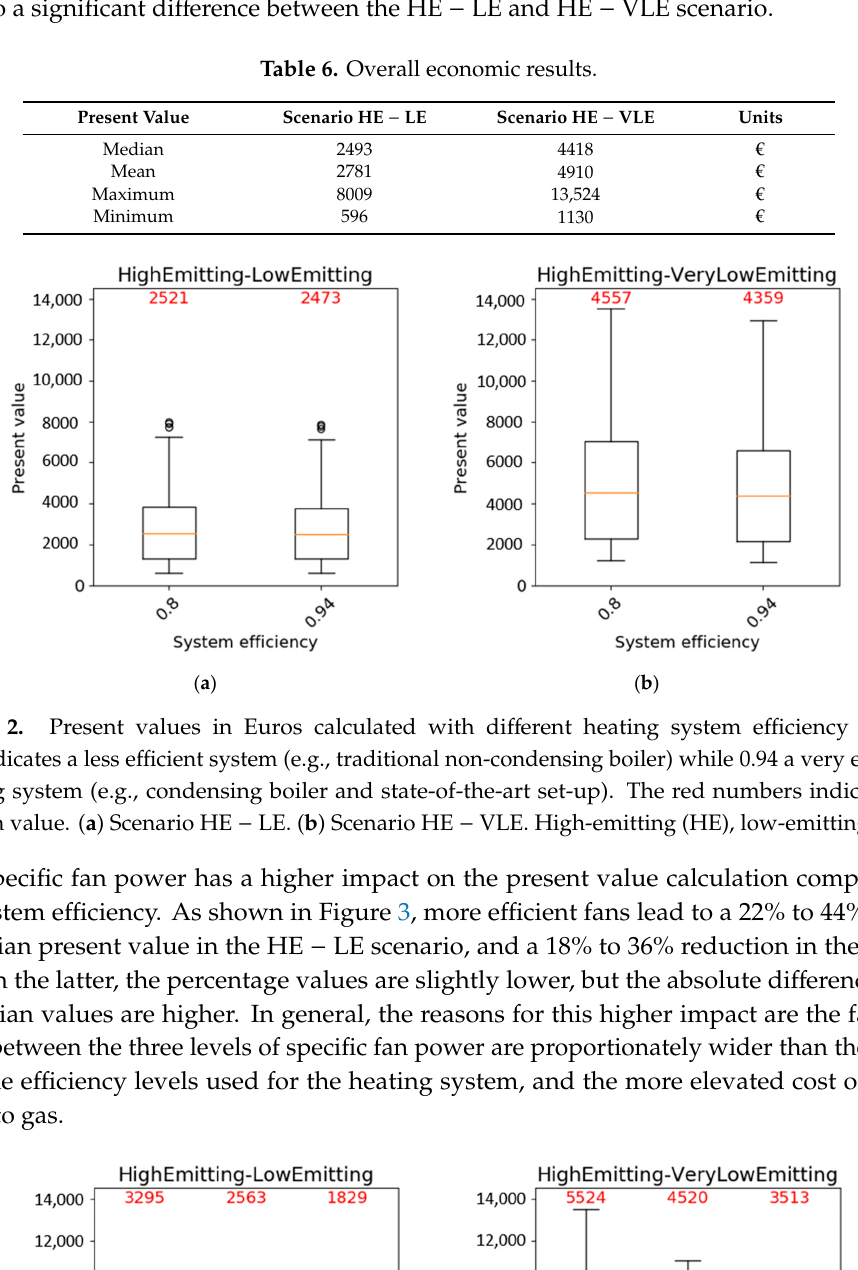
( b ) Figure 4. Present values calculated with different gas prices. ( a ) Scenario HE − LE. ( b ) Scenario HE − VLE.